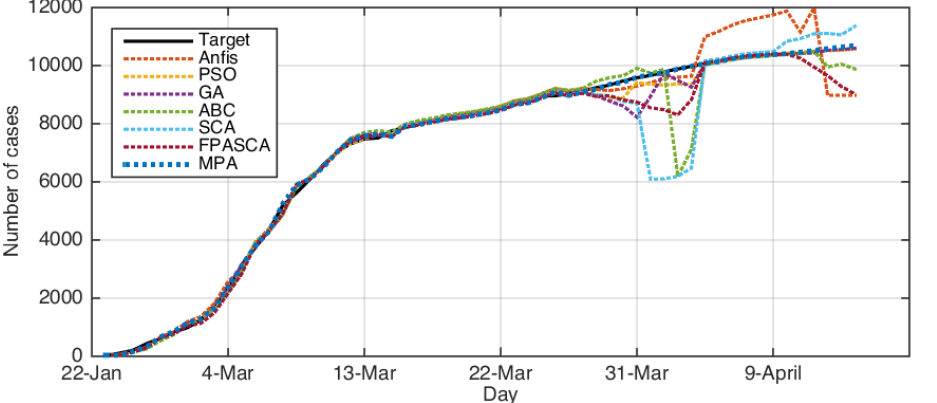
Figure 5. The results for Korea using ABC, ANFIS, FPASSA, GA, MPA, SCA, and PSO against real data